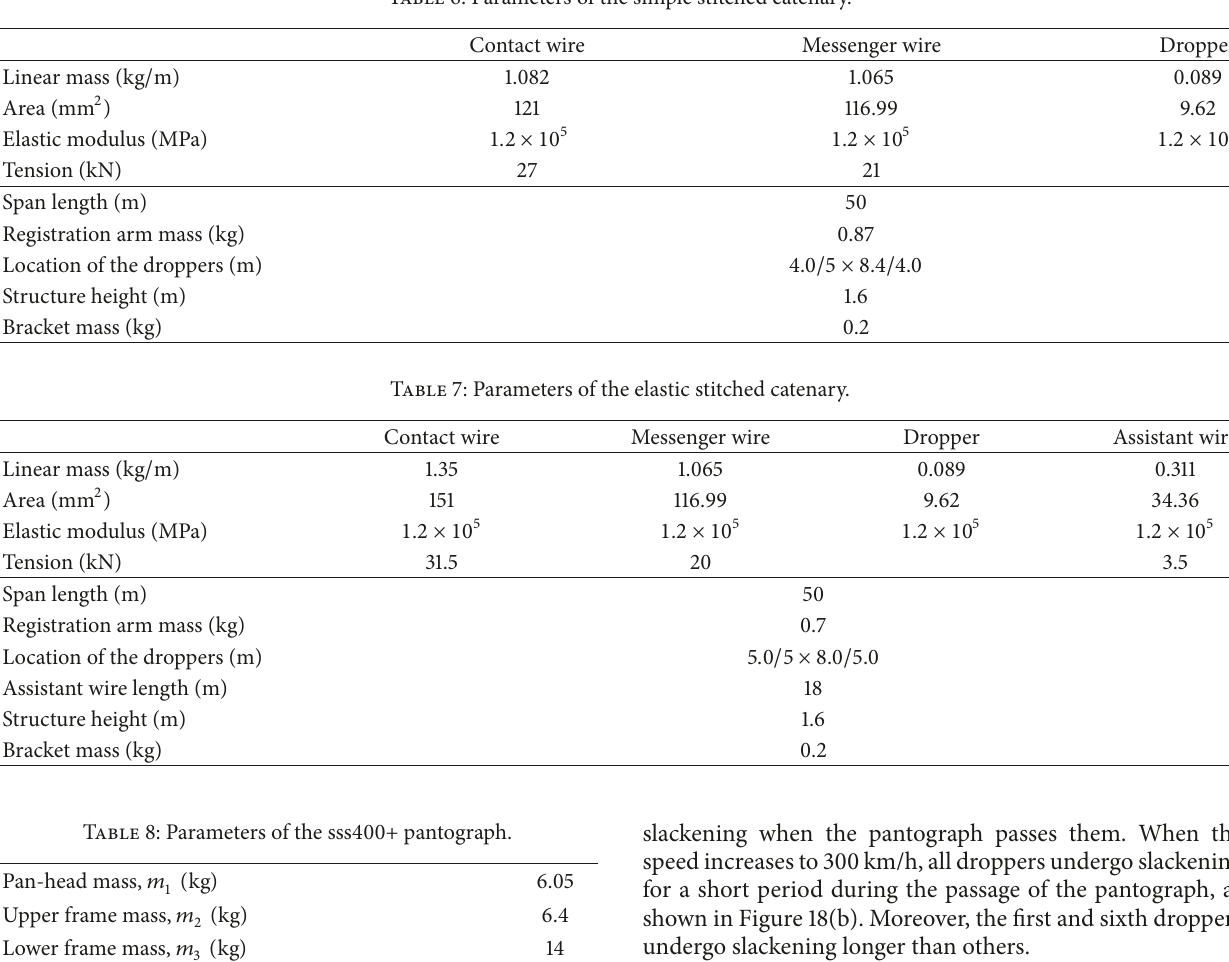
Table 6: Parameters of the simple stitched catenary.